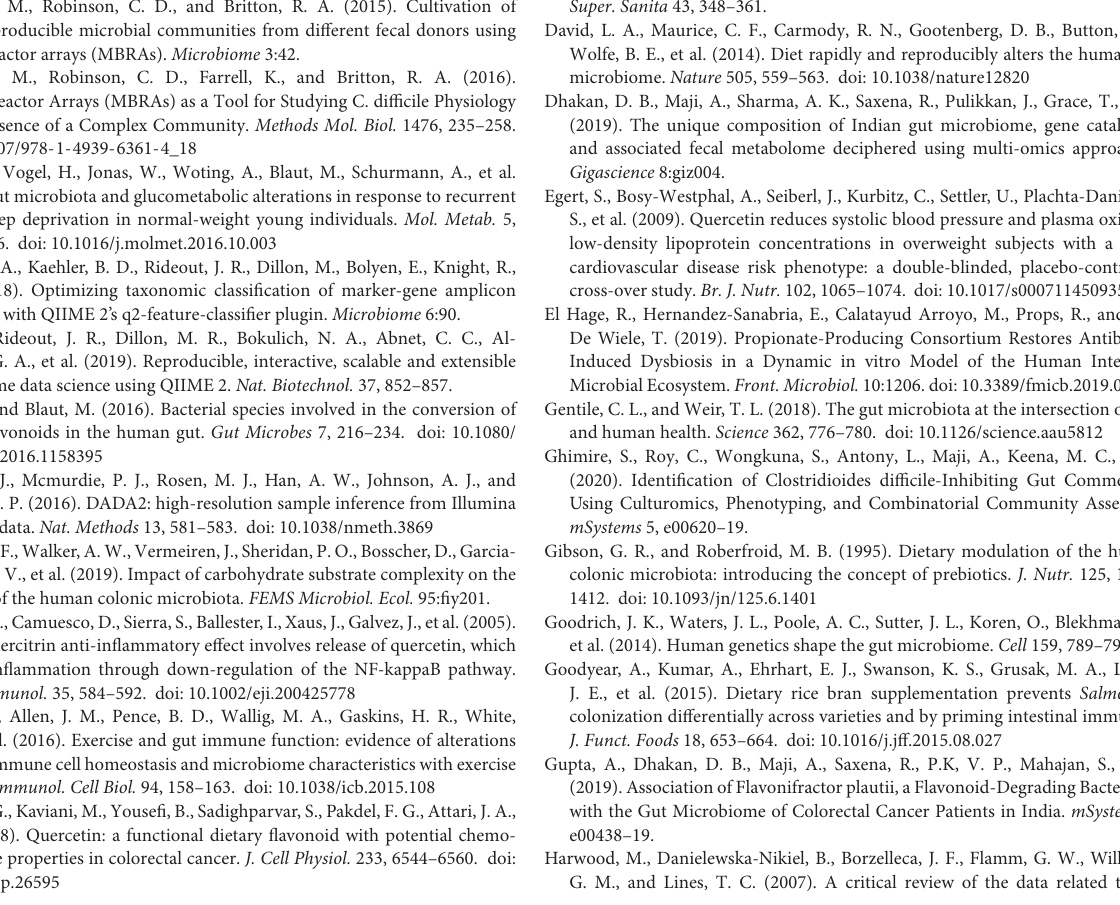
Statistically, PERMANOVA using adonis was calculated on the beta diversity with p = 0.004. The upper panel represents the beta diversity in early stages (day 4 and